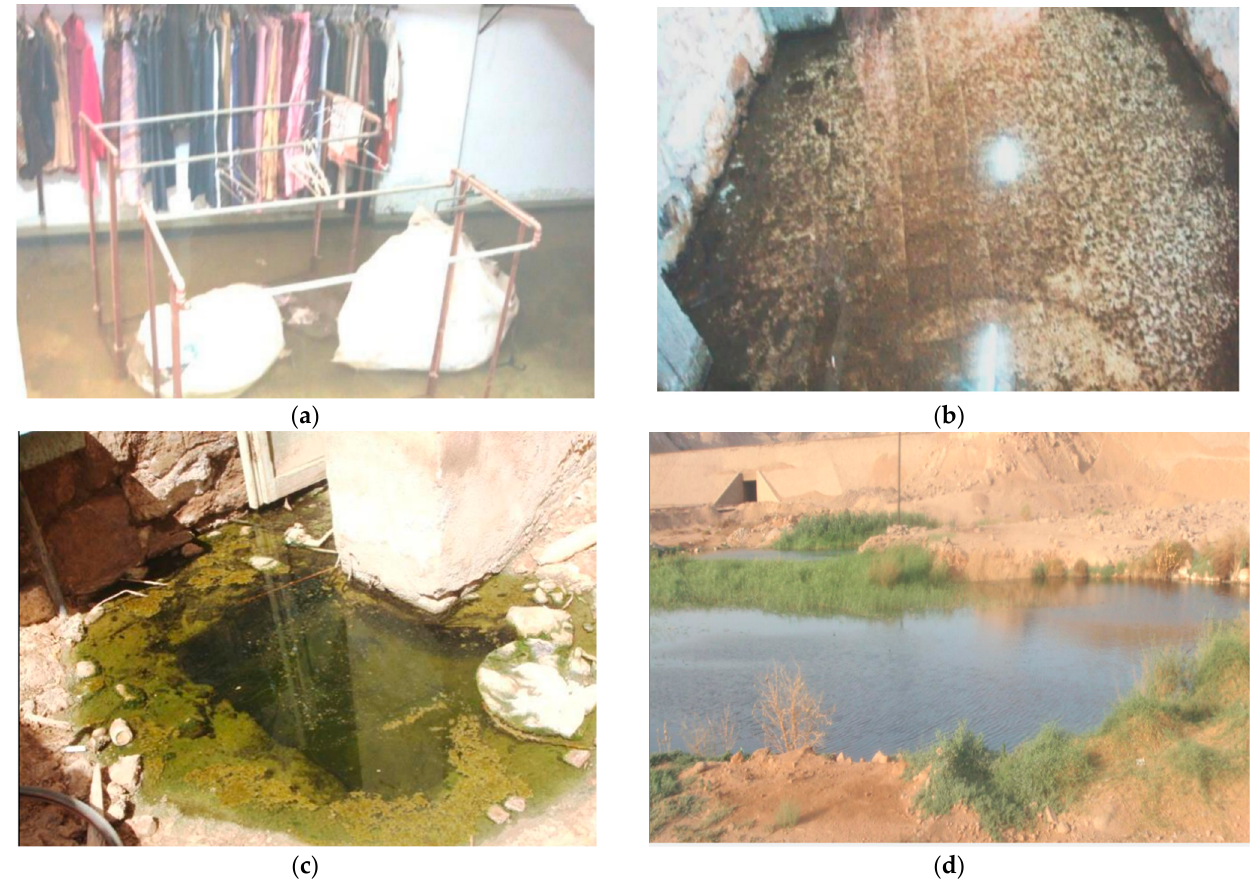
Figure 1. The bad effects of groundwater on the study area: ( a , b ) the effect of groundwater on buildings; ( c ) the effect of groundwater on foundations; and ( d ) formation of surface ponds.